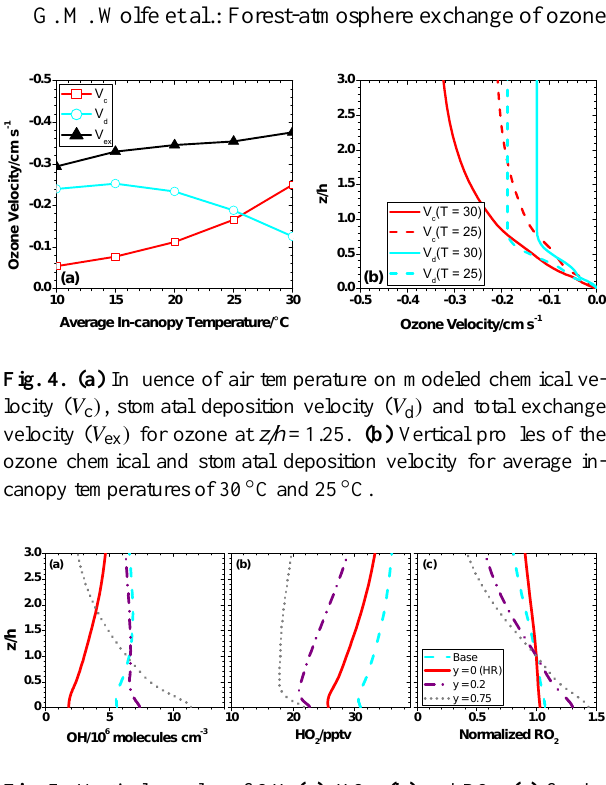
Fig. 5. Vertical profiles of OH (a) , HO 2 (b) and RO 2 (c) for the OH-yield sensitivity scenarios as described in the text. RO 2 con- centrations are normalized to canopy-top values of 129, 101, 268 and 564pptv for the base, HR, y = 0 . 2 and y = 0 . 75 scenarios, re- spectively. Note that the y = 0 . 75 case does not include an enhanced OH recycling